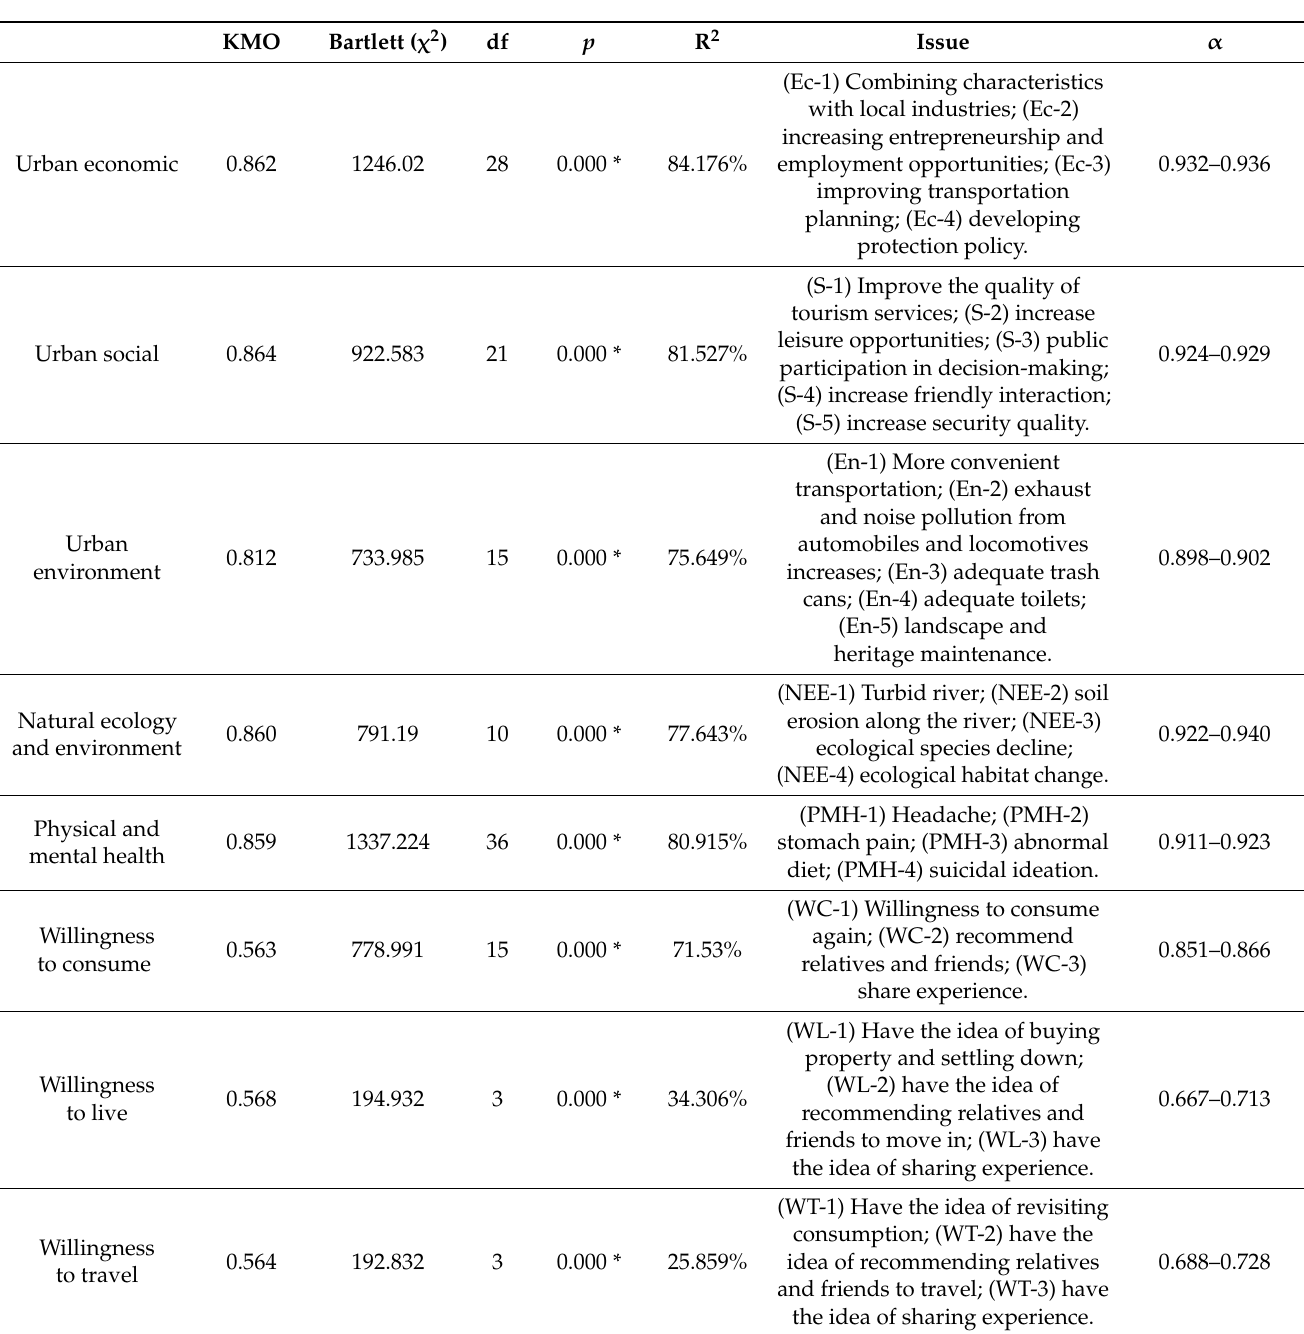
Table 1. Questionnaire analysis of the urban economy, urban society, urban environment, natural ecology, environment, willingness to consume, willingness to live, and willingness to